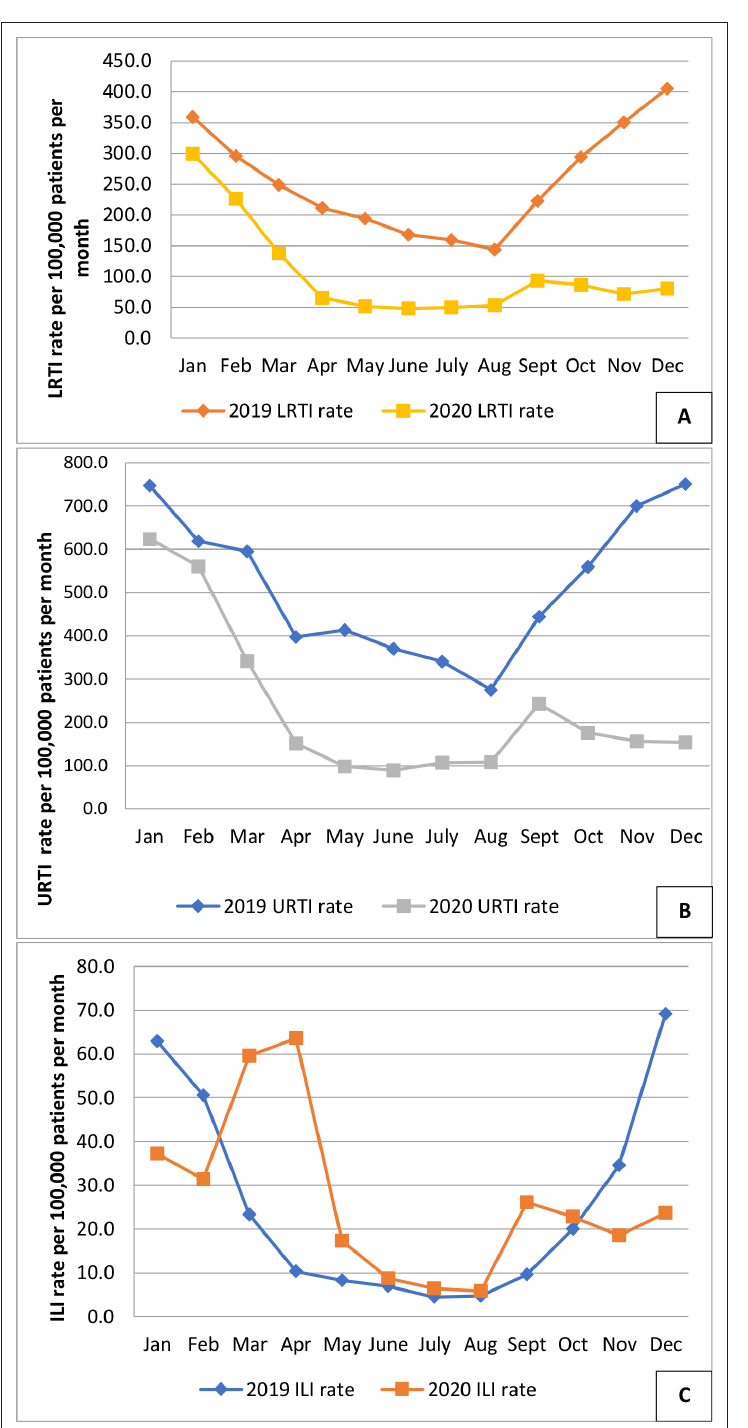
Figure 2 Comparison of monthly incidence of consultations for lower respiratory tract infections (Figure 2A), upper respiratory tract infections (Figure 2B), and influenza- like illness (Figure 2C), comparing 2020 with 2019 in the Research and Surveillance Centre dataset. There was a lower incidence of LRTI and URI in 2020 compared with 2019, with a small peak when pupils returned to school in September 2020. ILI peaked with the first wave of the COVID-19 pandemic, and also with the return to